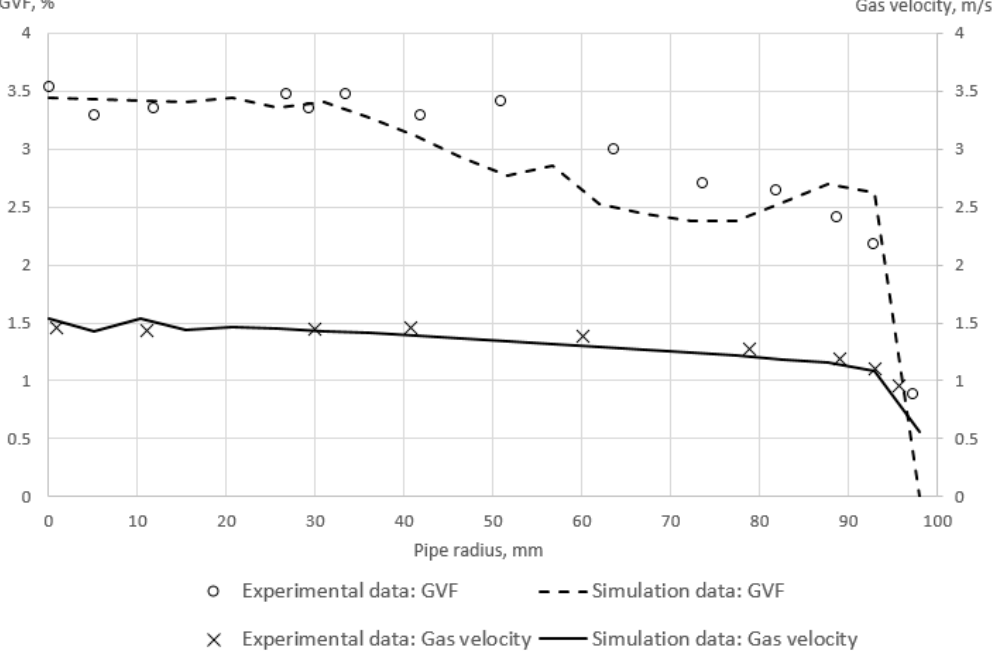
Figure 9. The gas volume fraction distribution and gas velocity across the pipe radius according to the conducted simulation and experimental study by Prasser et al. [47].